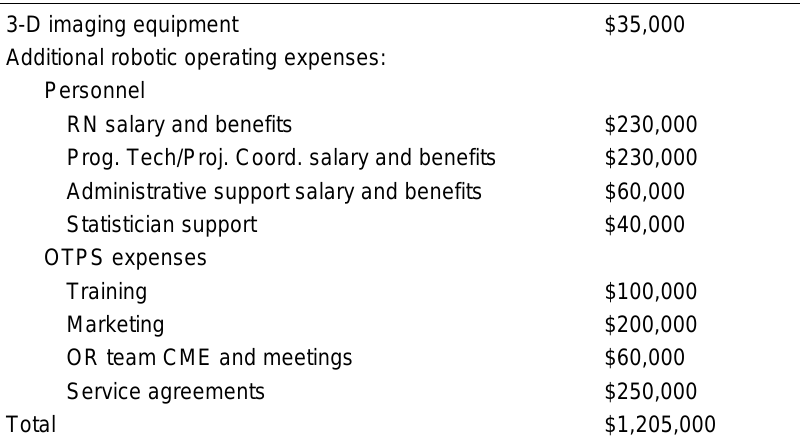
Robotics Program 3-Year Projected Additional Expenses (Exclusive of Robot, Supplies, and